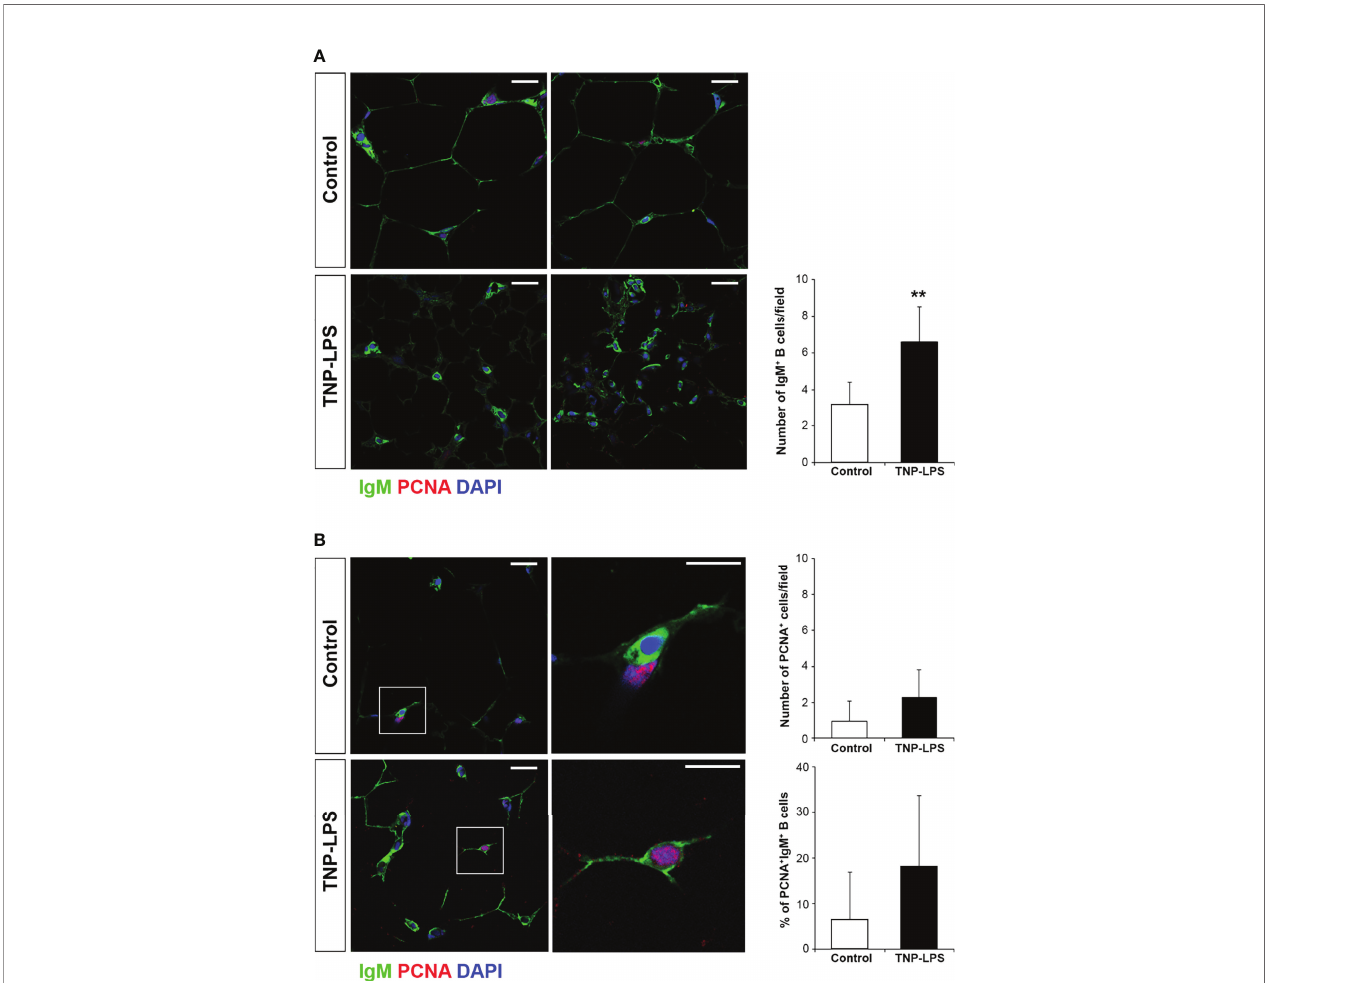
FIGURE 8 | Proliferation of IgM + B cells in AT cells after the intraperitoneal immunization of rainbow trout with TNP-LPS. Confocal microscopy images of rainbow trout AT sections obtained from fi sh intraperitoneally immunized with the antigen TNP-LPS and mock immunized (control) at day 21 post-immunization. Sections were labeled with anti-IgM (green) in combination with the anti-proliferating cell nuclear antigen (PCNA) (red). All sections were also counterstained with DAPI (blue). (A) Representative images for each condition are shown (scale bars = 20µm) along with a graph showing the mean number of IgM + B cells in immunized fi sh compared to control fi sh, calculated in 15 digital fi elds (400 x magni fi cation) from 6 different individuals (mean + SD; n = 6 fi sh). Asterisks denote signi fi cantly different values between indicated groups (**p ≤ 0.01). (B) Representative images for each condition are shown (scale bars = 20µm) along with higher magni fi cation images from control and TNP-LPS immunized tissues (white square; scale bar = 5 µm). Note that in non-proliferating cells, nuclei appear blue whereas they appear violet in proliferating cells. Graphs showing the mean number of total PCNA + proliferating cells as well as the mean percentage of proliferating IgM + /PCNA + cells in immunized fi sh compared to those in control fi sh are also included, calculated in 15 digital fi elds (400 x magni fi cation) from 6 different individuals (mean + SD; n =